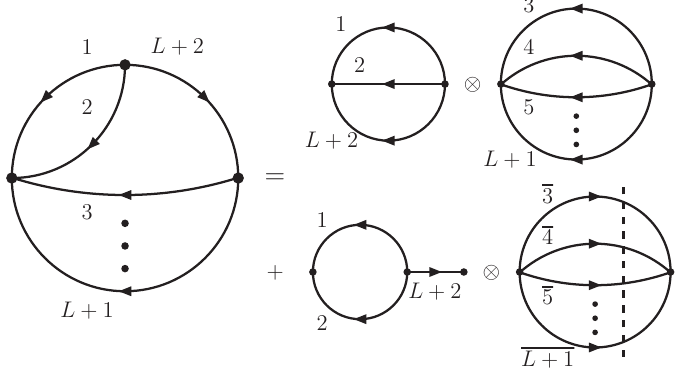
Figure 6 . Dual decomposition of NMLT ( L ) in terms of loop configurations with lower topological